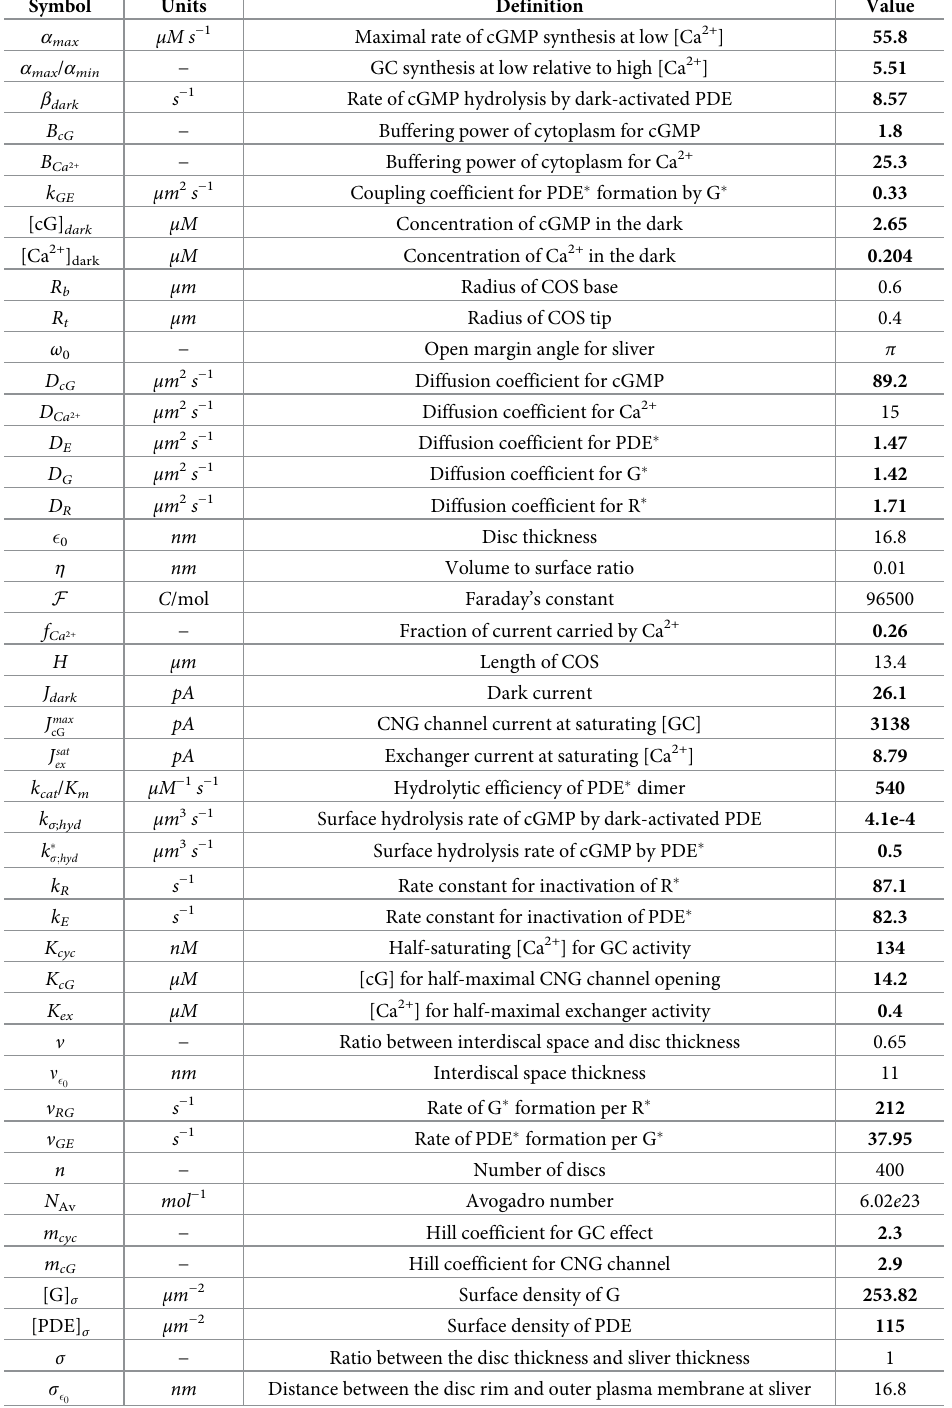
Table 10. Parameter values for a mouse cone found by minimizing the rms error between experiment and model predictions for a flash producing 940 photoisomerizations according to the Metropolis-Hastings random